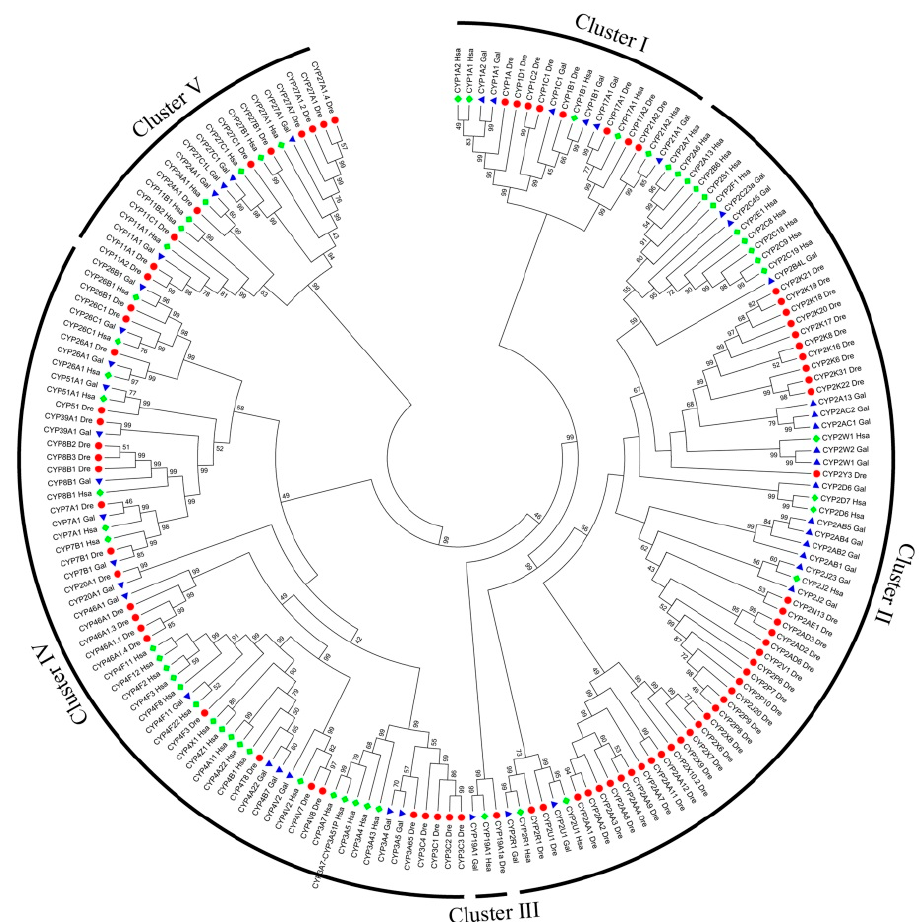
Figure 1. Phylogenetic tree of Cytochrome P450 (CYP) from human, chicken, and zebrafish genomes. The phylogenetic tree shows 57 CYPs from Homo sapiens (Has, highlighted in green rhombus), 45 CYPs from Gallus gallus (Gal, highlighted in blue triangles), and 83 CYPs from Danio rerio (Dre, highlighted in red circles). The phylogenetic tree was built in MEGA5 using the neighbor-joining method with 1000 bootstrap replicates.